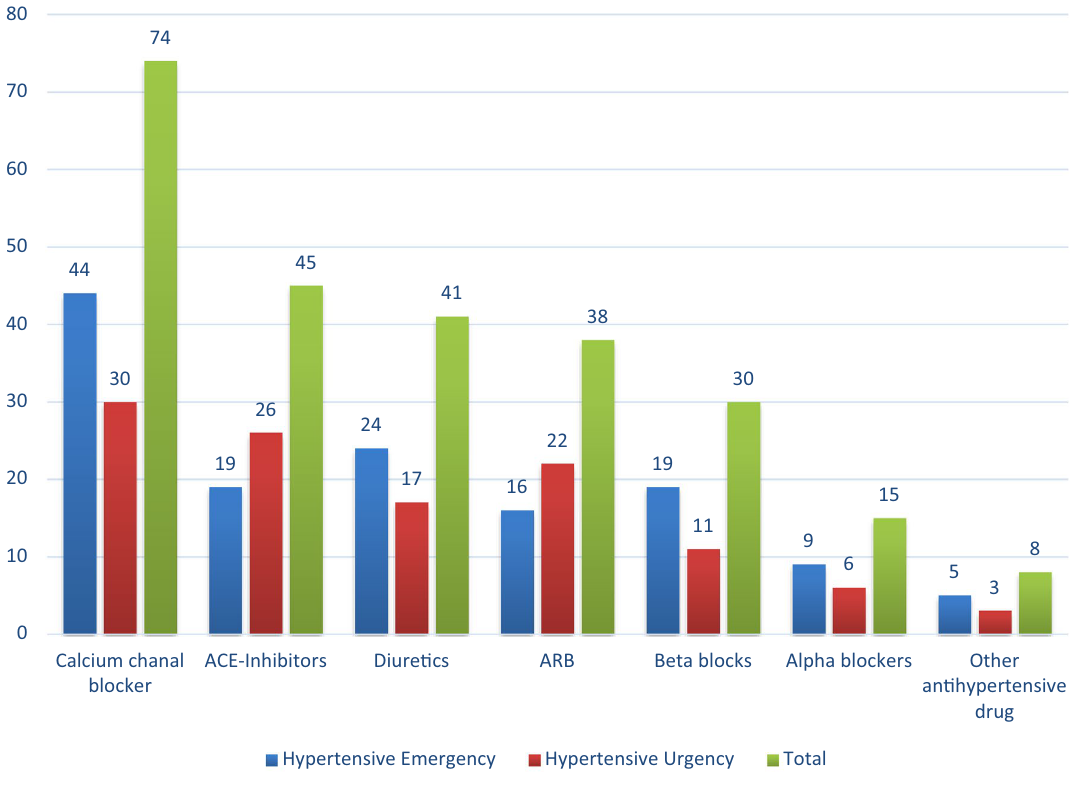
Figure 2. Distribution of antihypertensive medications.